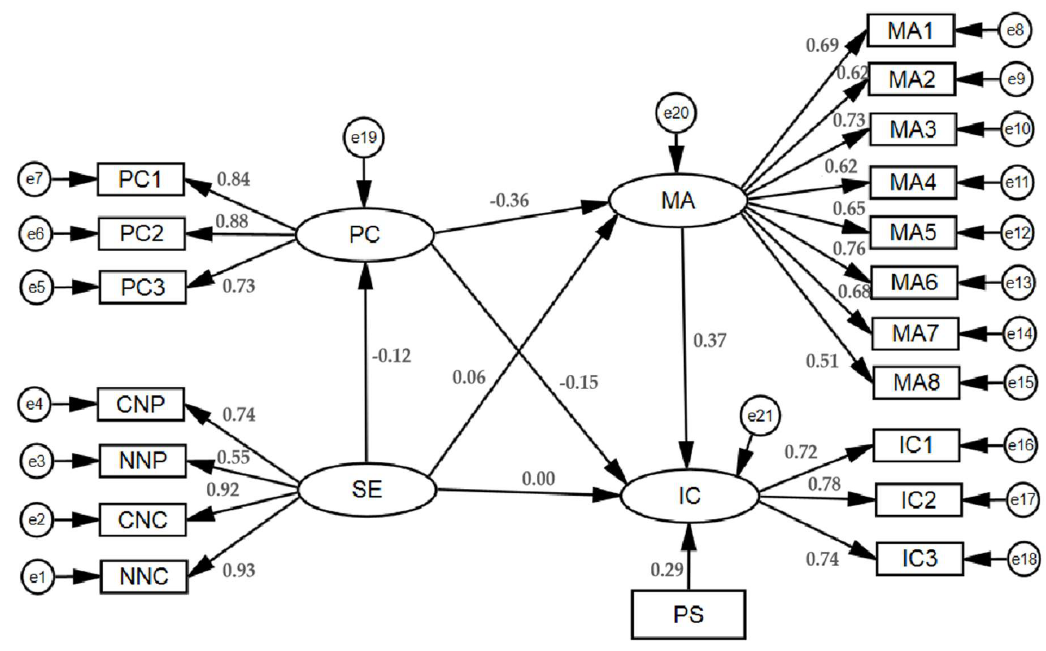
Figure 3. Structure equation model diagram.